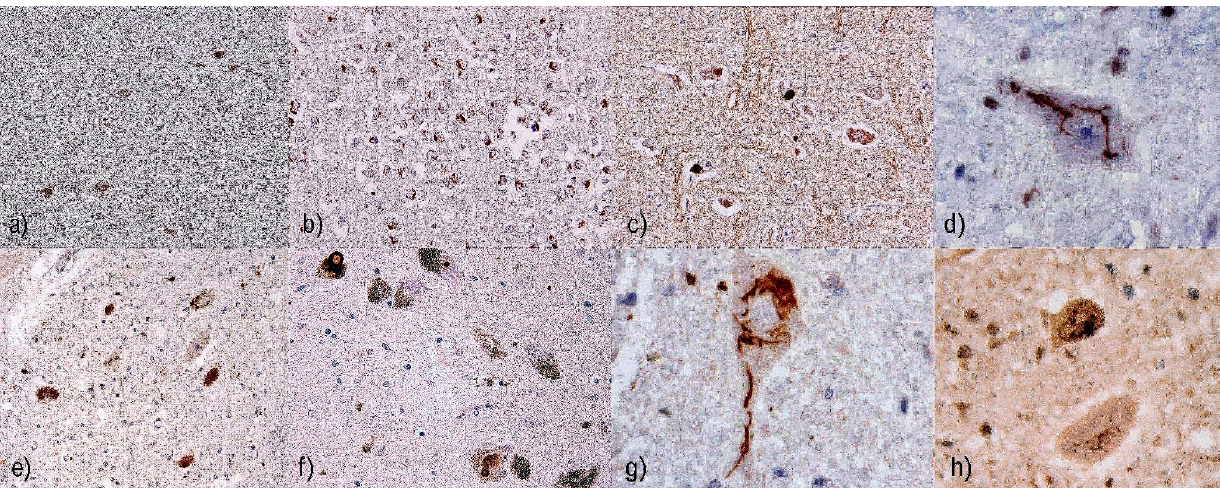
Figure 2. ( a ) Overview of inclusions positive in reaction with anti-phosphorylated TDP-43 (pTDP-43) antibody, original magnification 100×. ( b ) pTPD-43 positive cytoplasmic inclusions in the hippocampus are considered one of the characteristic features of the variant with C9orf72 mutation, magnification 100×. ( c ) Cytoplasmic pTDP-43-positive cytoplasmic inclusions in the hypoglossal motor neurons, original magnification 200×. ( d ) Detailed shape of cytoplasmatic pTDP-43-positive inclusion in the lower motor neuron. The original magnification 400×. ( e ) Inclusions detected with anti-p62 antibodies in the mesencephalic nuclei. The original magnification was 100×. ( f ) Inclusions detected by anti-p62 antibody seen in the neurons of mesencephalic nuclei. The original magnification 200×. ( g ) Detailed morphology of p62-positive inclusions in the cytoplasma of upper motor neuron, original magnification 400×. ( h ) Morphology of ubiquitin-positive “skein-like” inclusions with characteristic elongated or fibrous shape, which form bizarre spherical structures in the perikaryon of neurons. The original magnification was 400×.